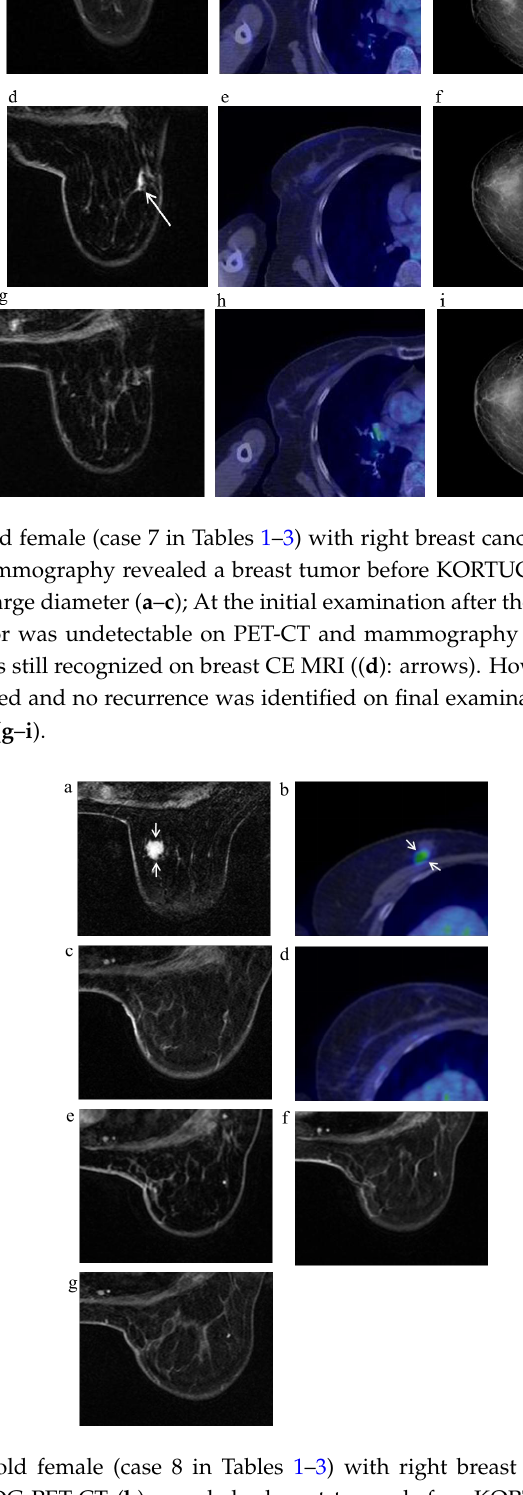
Figure 2. A 64-year-old female (case 3 in Tables 1-3) with left breast cancer (cT2N0M0). CE breast MRI, PET-CT and mammography revealed a breast tumor before KORTUC II therapy, the region of tumor